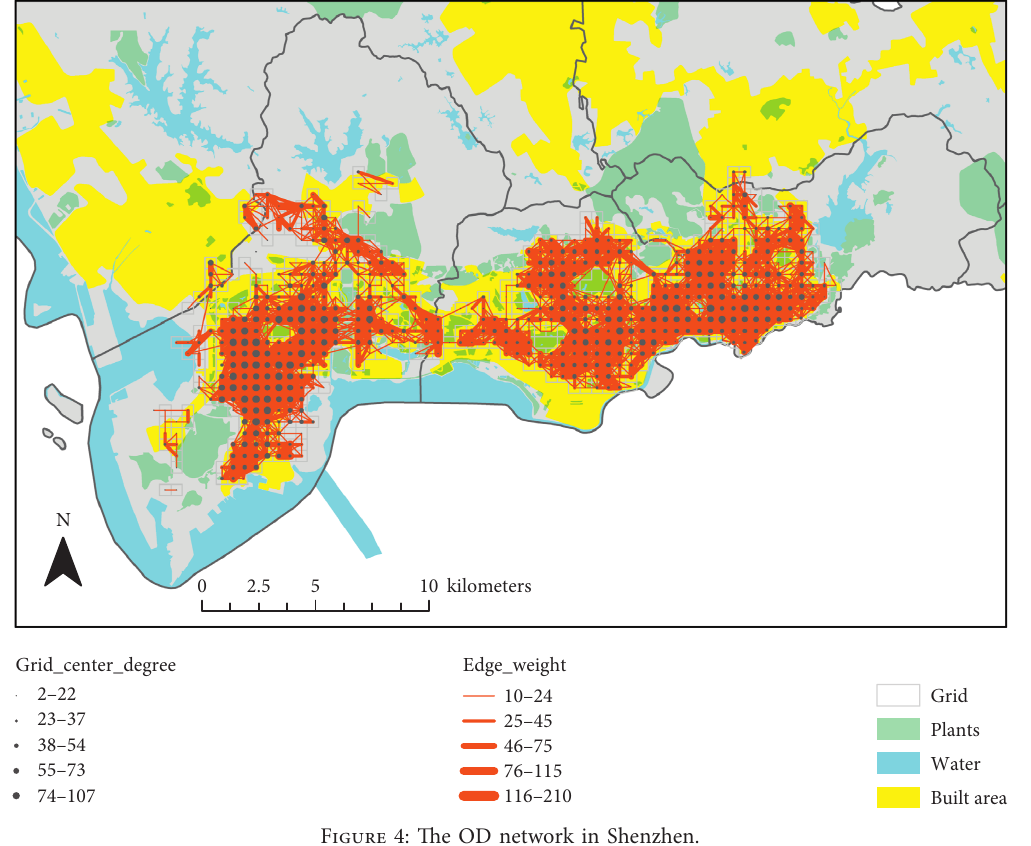
Figure 4: The OD network in Shenzhen.